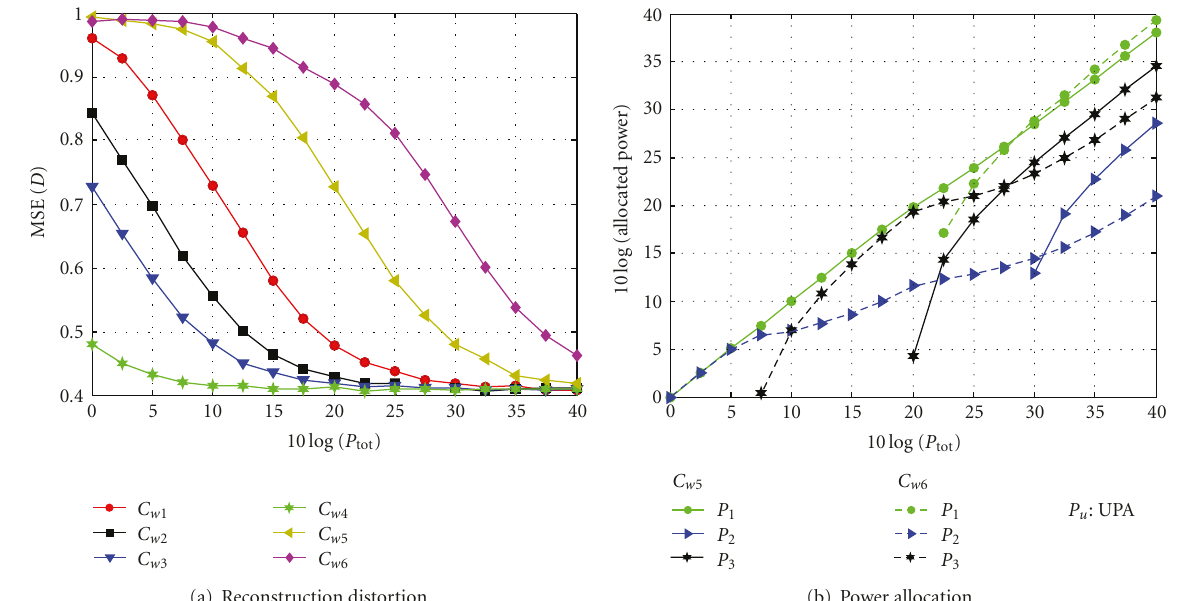
Figure 6: E ff ect of channel SNR—Ex1.